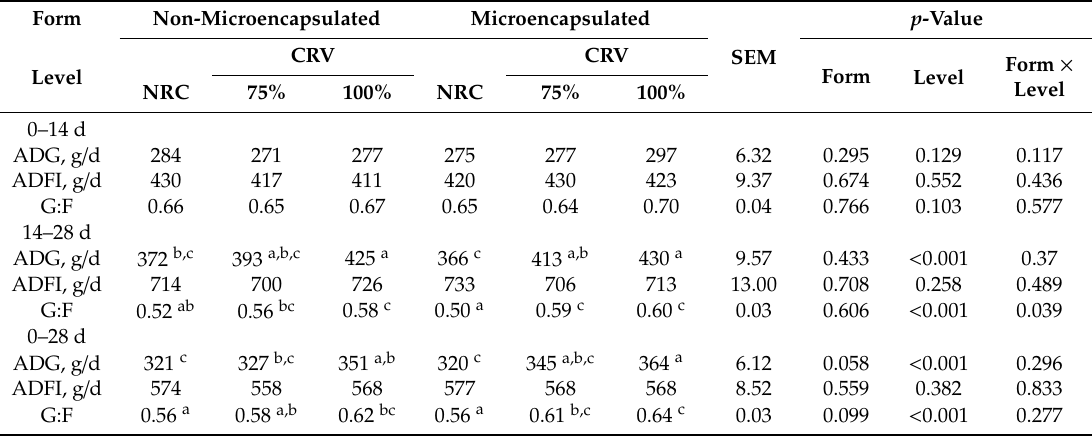
Table 5. E ff ects of vitamin forms and levels on growth performance for weaned piglets. Form Non-Microencapsulated Microencapsulated